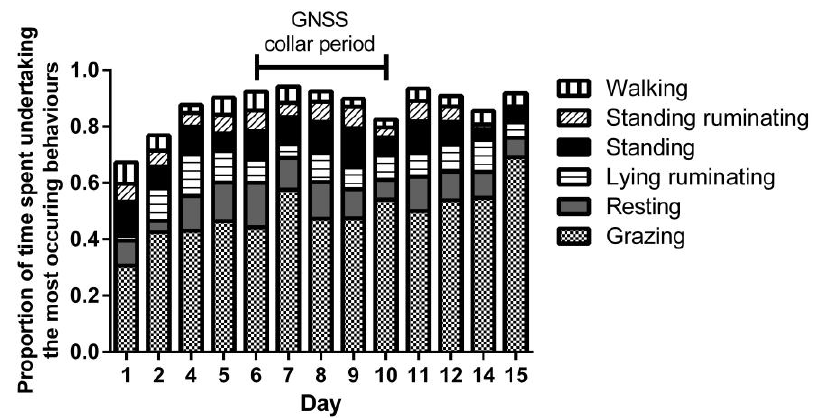
Figure 4. Proportion of time spent undertaking each of the six most commonly recorded behaviours each day during daylight hours over the duration of the study. Observations were not recorded on Days 3 and